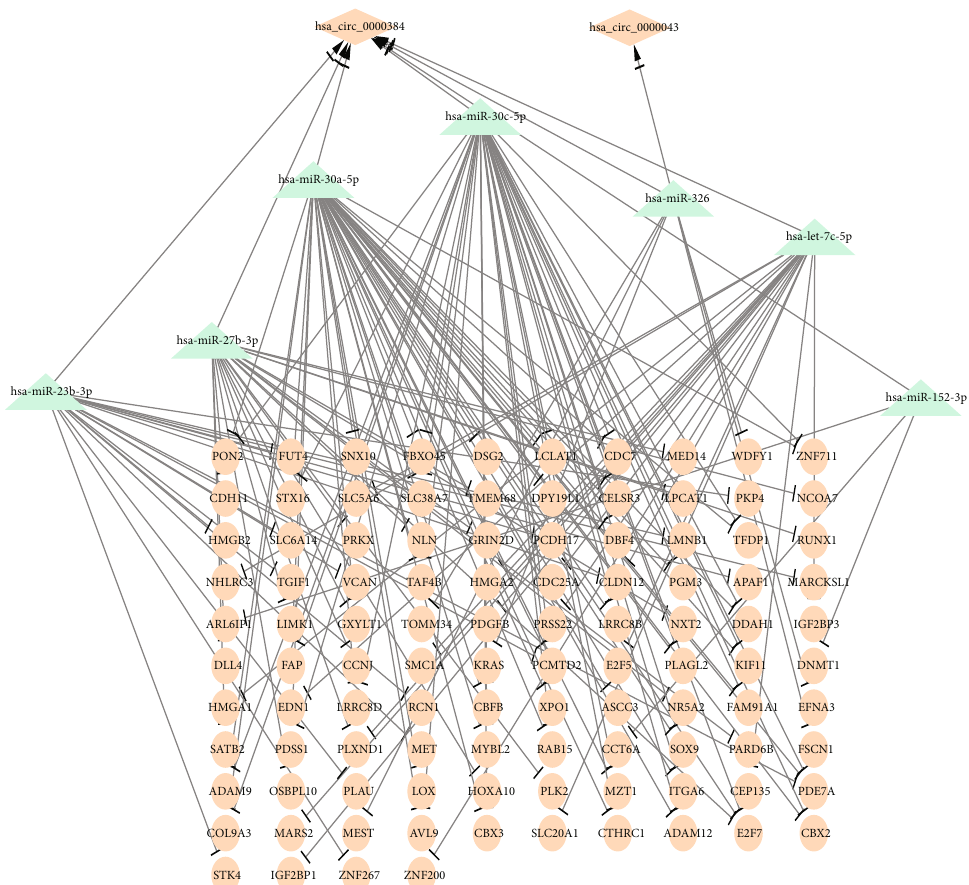
Figure 3: The DEcircRNA-DEmiRNA-DEmRNA network in GC, consisting of 2 DEcircRNAs, 7 DEmiRNAs, and 104